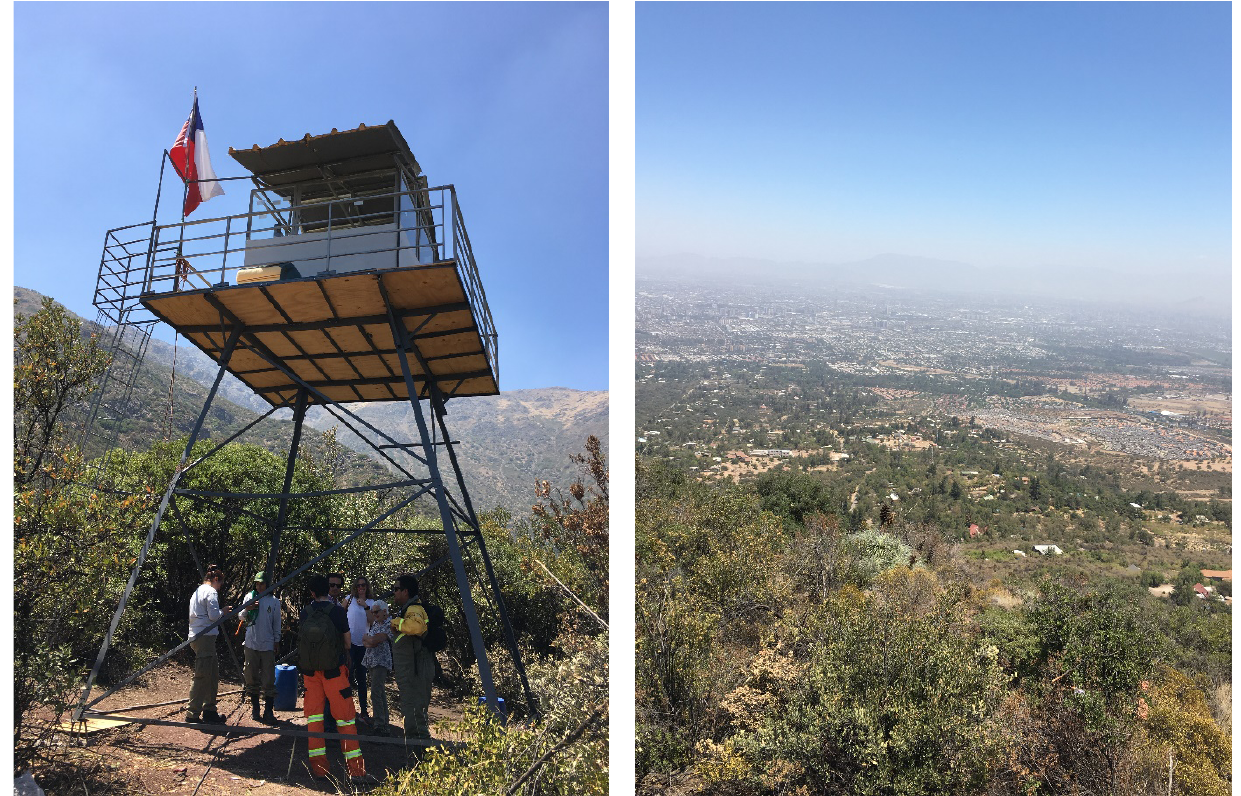
Figure 5. From left to right: The BEAF watchtower and its view of Santiago. Source: Authors in January 2018. which are closely connected to our Rancièrean